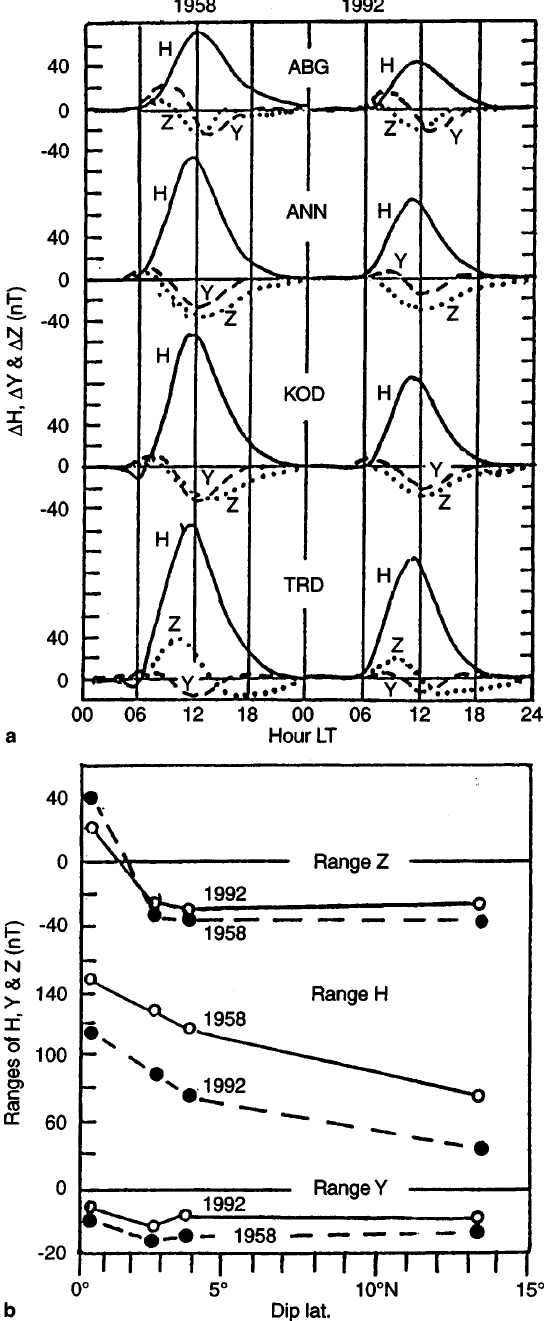
Fig. 1. Annual mean solar daily variations of the three components of the geomagnetic field, horizontal (H), eastward (Y) and vertical (Z) for the years 1958 and 1992 at the four observatories in India. Trivandrum ( TRD ), Kodaikanal ( KOD ), Annamalainagar ( ANN ), and Alibag (